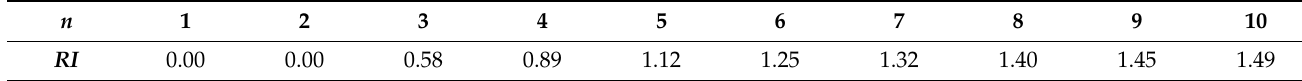
Table 4. Random Consistency Index ( RI ) values for n variables.